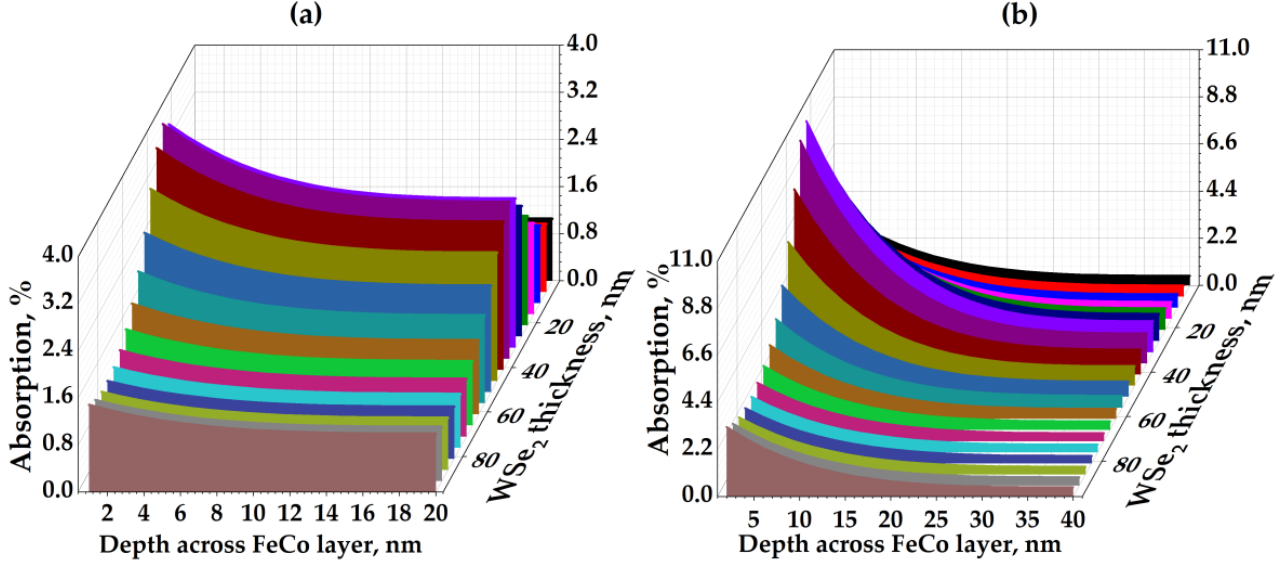
Figure 5. Calculated dependences of the optical absorption on the depth across the FM layer and on the thickness of the TMD layer in ( a ) FeCo20/WSe 2 and ( b ) FeCo40/WSe 2 .